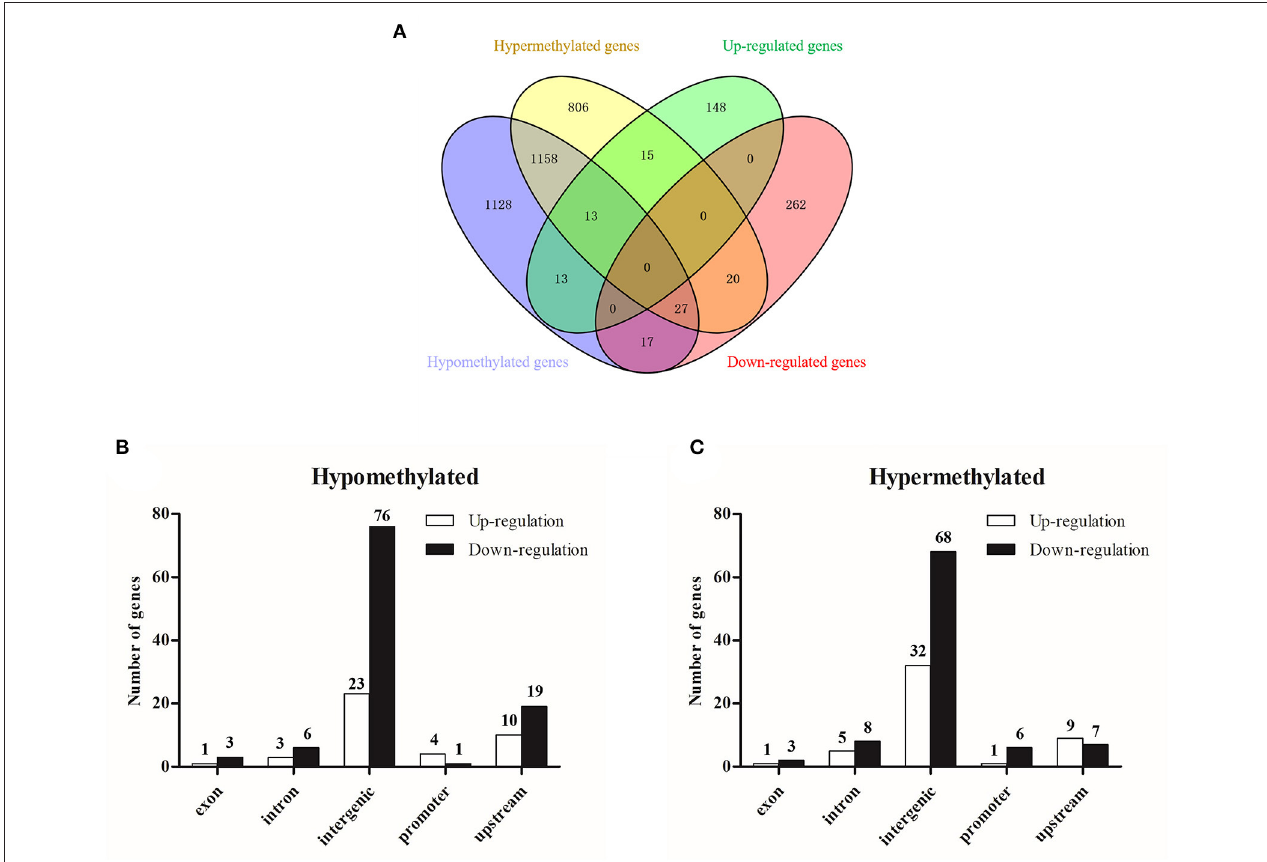
TABLE 3 | Differentially methylated and regulated genes with methylation profiles in promoter regions. GeneID Chromosome Genomic context Methylated region Fold change